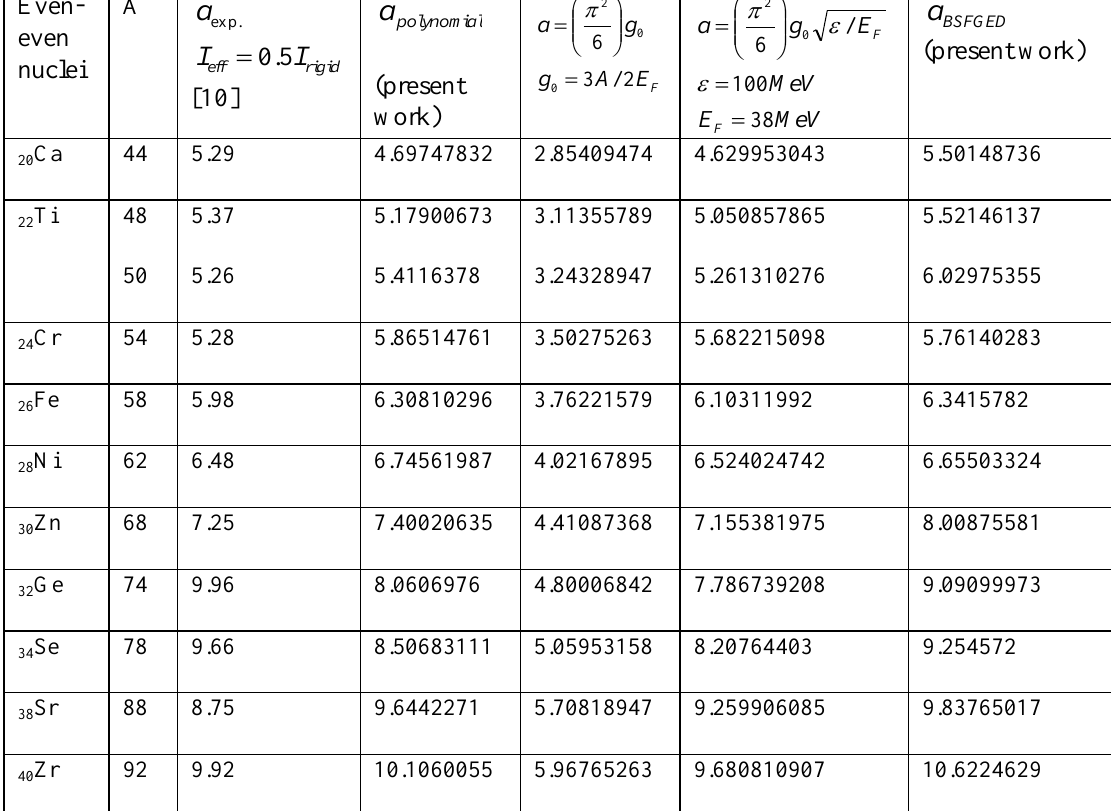
Fig.3: The state density calculated for 58 Fe and 246 Cm as a function of excitation energy with different values of the level density parameter taken from Table 1. All the results are compared with the experimental data of the state density [11]. Table 1: The level density parameter-a calculated in this work for various 106 nuclei using different